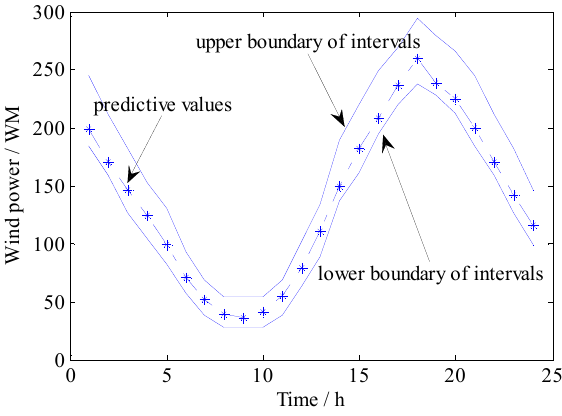
Figure 6. Optimal wind power confidence intervals (Case 1).